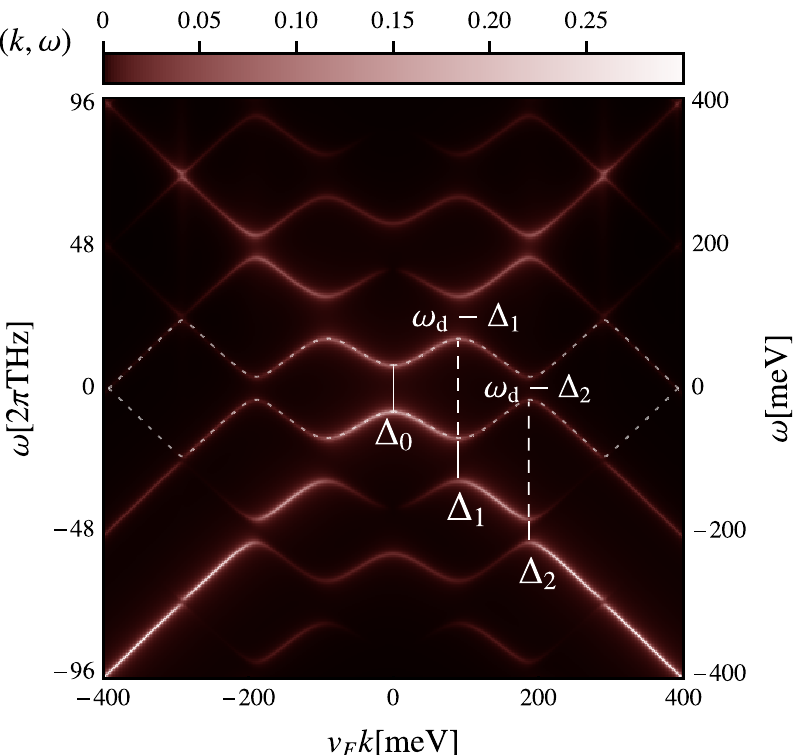
Fig. 1 Electron distribution of light-driven graphene, revealing its Floquet states. The electron distribution n ( k , ω ) of graphene driven with circularly polarized light at the driving frequency ω d = 2 π × 48 THz ≈ 200 meV and fi eld strength E d = 26 MV m − 1 . The distribution n ( k , ω ) depends only on the momentum k = ∣ k ∣ . This quantity displays the steady state occupation of the Floquet-Bloch band structure. The one-photon resonance gap Δ 1 at k = ω d / (2 v F ), the two-photon gap Δ 0 at the Dirac point, and the two-photon gap at k = ω d / v F are highlighted for clarity. v F is the Fermi velocity. Additionally, the complementary gaps ω d − Δ 1 and ω d − Δ 2 are indicated. The dotted lines indicate the Floquet energies of the fi rst Floquet